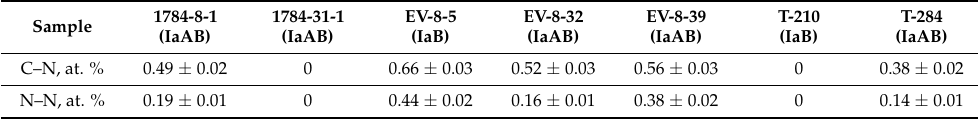
Table 2. Nitrogen content in C–N and N–N bonding states in the diamonds measured by